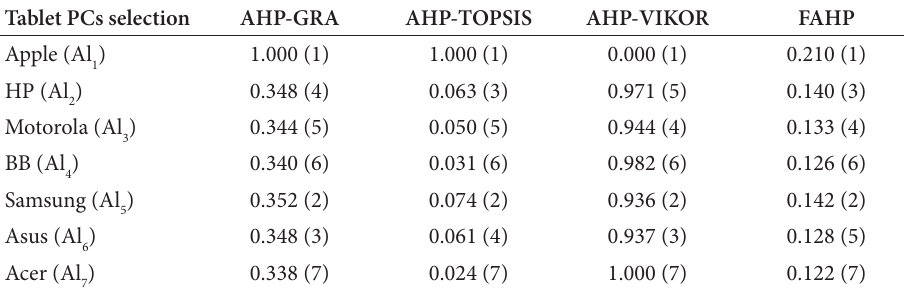
Table 9. Summary of preference order ranking by four MCDM methods Tablet PCs